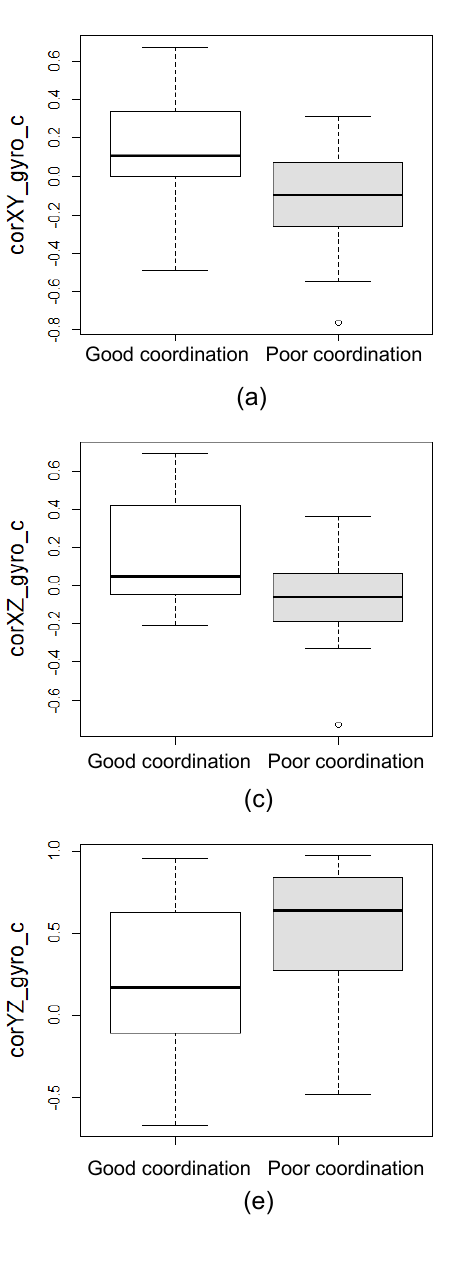
Figure 7. Box-and-Whisker plots on top five features selected in Method-8 for good and poor coordination during pelvis rotation: (a) correlation between x and y components of angular velocity of chest, (b) covariance between y and z components of angular velocity of chest, (c) correlation between x and z components of angular velocity of chest, (d) covariance between x and z components of angular velocity of chest, and (e) correlation between y and z components of angular velocity of